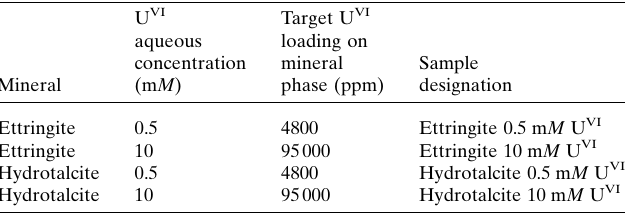
Table 1 Details of the U VI -contacted cement mineral